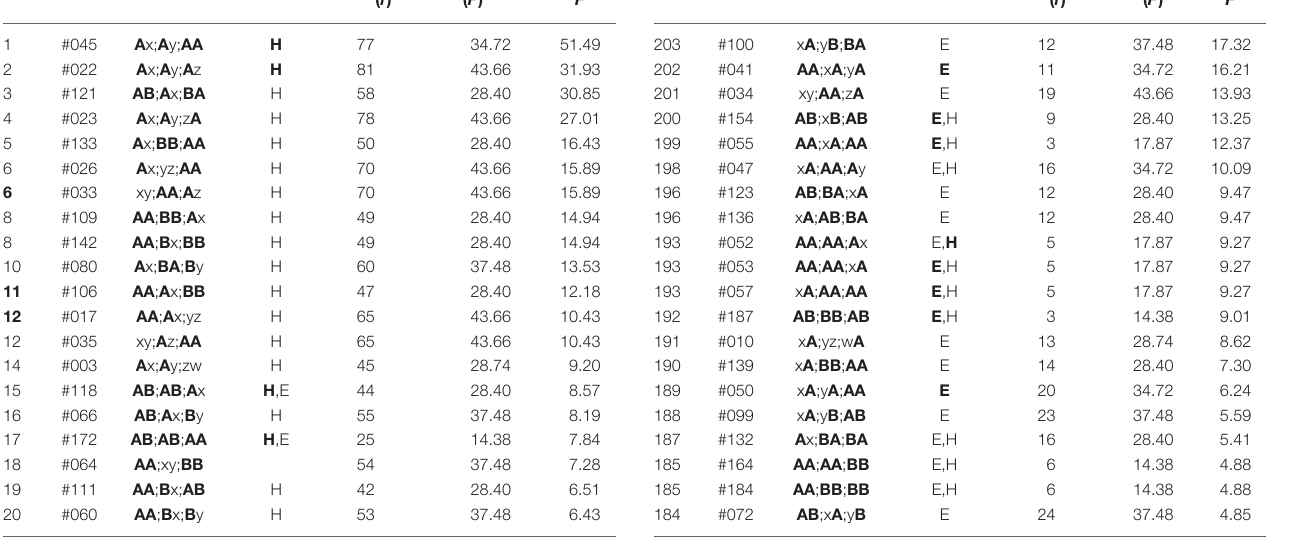
TABLE 2 | The bottom-twenty arrangements in The Complete Haiku Works of Mantaro Kubota , wherein there are 6064 poems included. Expected (f - F) 2 / Rank No. Arrangement Correlation Surveyed ( f ) ( F ) F